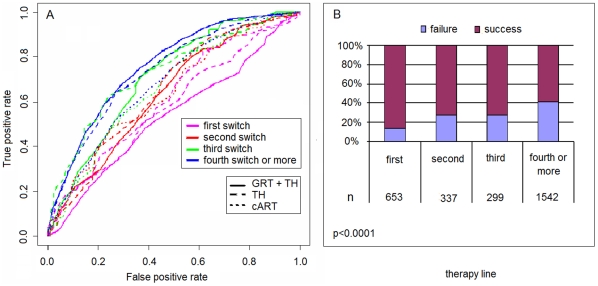
Models' performance evaluation by therapy line.Plot (panel A) of AUC of 10-fold CV for models (i), (ii) and (iv) by stratifying for therapy line (SD8G). Performance decrease significantly by decreasing the number of drug switches, and the loss in AUC is as pronounced in TH-based as in the other models. The proportion of virological successes (panel B) decreases significantly by increasing the therapy line (p<0.0001).